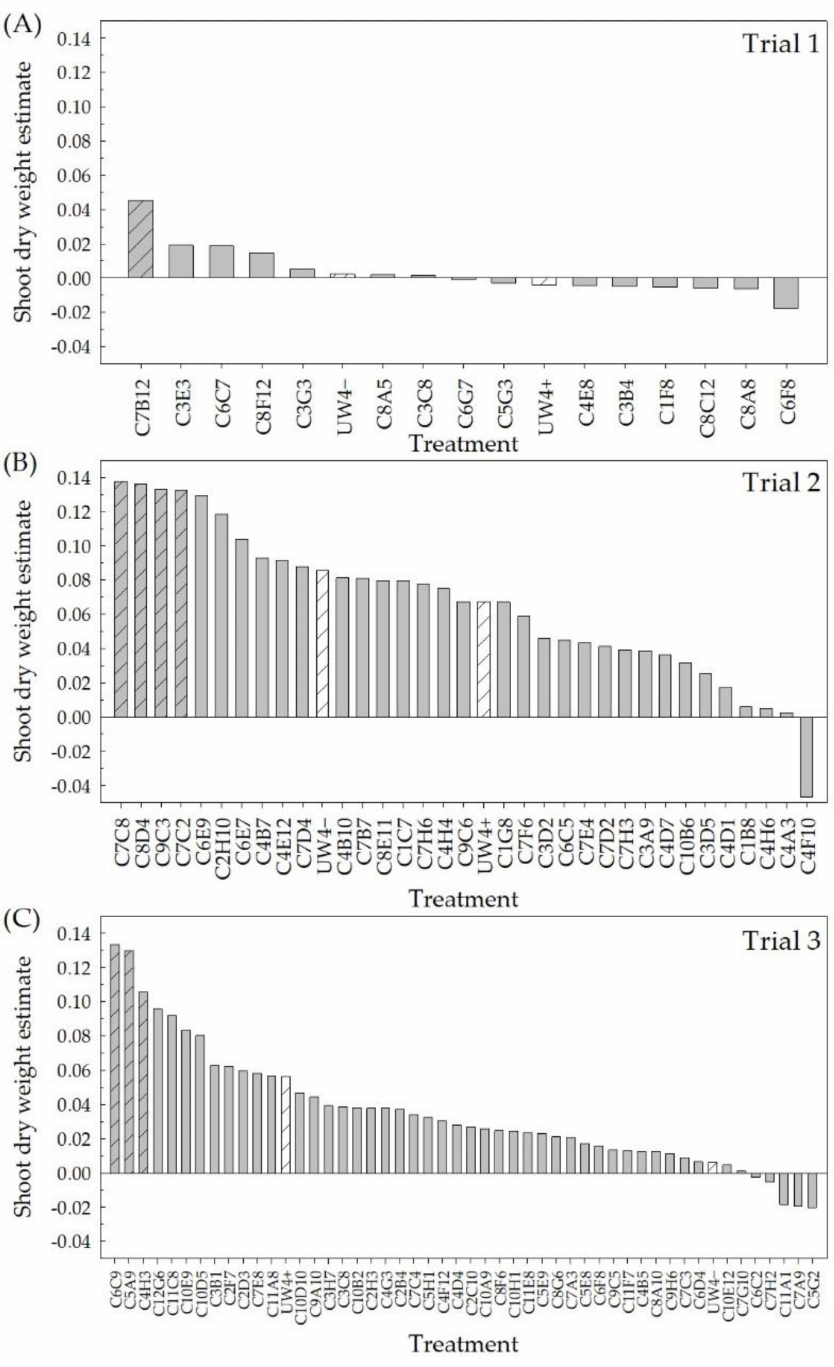
Figure 2. Shoot dry weight (DW) of Petunia × hybrida ‘Picobella Blue’ treated with bacterial isolates from a greenhouse rhizosphere collection grown under low-fertility conditions (25 mg L − 1 N) in the high-throughput greenhouse trials. Shoots were harvested 6 weeks after transplant. The 94 isolates were evaluated in three different groups, trial 1 ( A ), trial 2 ( B ), and trial 3 ( C ) ( n = 12). Estimates of the treatment effect compared to the negative control (no bacterial treatment) from the linear mixed-effects model were ranked. Positive values indicate strains that performed better than the negative control, whereas negative values indicate those that performed worse. Pseudomonas putida UW4+ and UW4 − , which were included as checks, are represented by white bars with slanted lines. The top 10% of the total strains were then selected from this ranking (gray bars with slanted